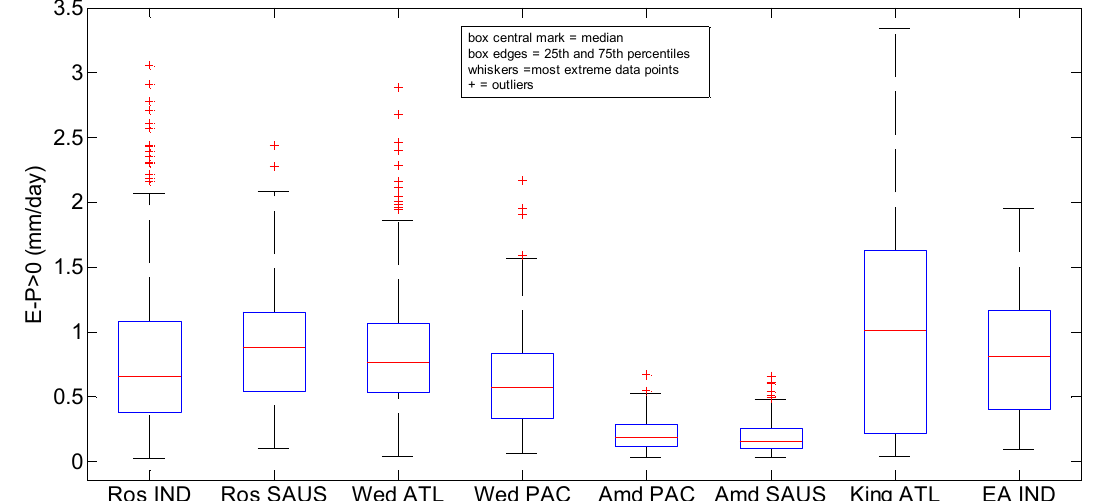
Figure 4. Boxplot of the monthly mean moisture sources ((E − P)i10 > 0 in mm / day) for the period 1980–2015. The central red mark indicates the median, blue boxes are the 25th and 75th percentiles, black bars (whiskers) extend to the most extreme data points not considered outliers, and the outliers are plotted individually using the ‘ + ’ symbol. Note: the mean values are obtained over the area delimited by the annual 75th percentile (black line in Figure 2).